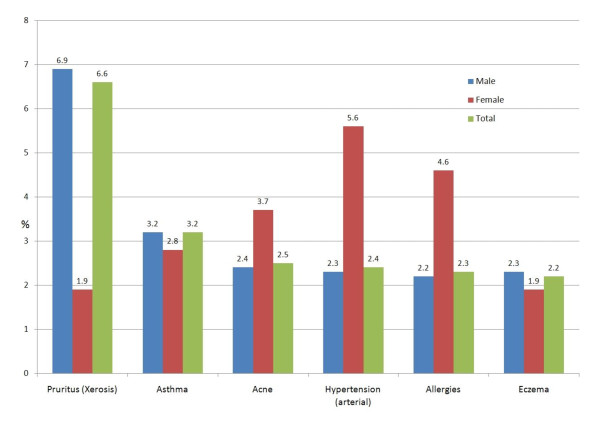
Health problems coded as general internal medicine (29.9%; 95%CI 28.0-31.8)